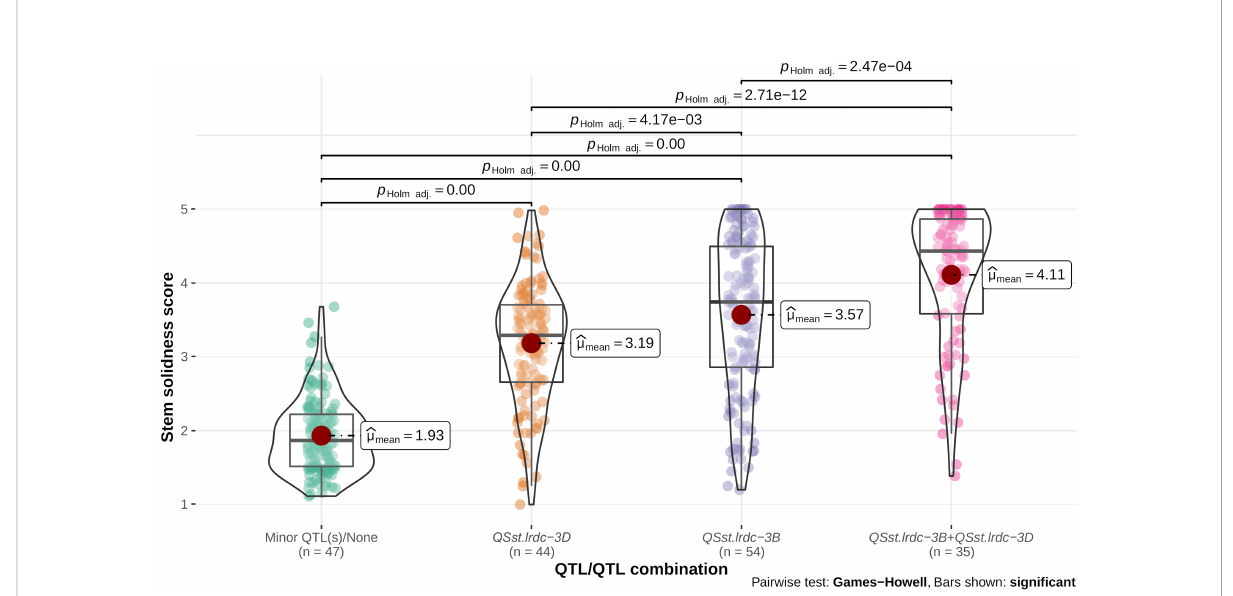
FIGURE 9 Violin plot and box plot distribution of stem solidness score in doubled haploid lines carrying (i) minor QTL(s)/none, (ii) major QTL QSst.lrdc-3D , (iii) major QTL QSst.lrdc-3B , and (iv) major QTL combination QSst.lrdc-3B and QSst.lrdc-3D in ‘ Sadash/P2711 ’ population. The violin plots (transparent) and different color- fi lled circles represent the data distribution. Quartiles and medians are represented by boxes and continuous lines (gray color), respectively. The mean is shown by dark red color dots. Whiskers extend to the farthest points that are not outliers. Signi fi cant differences are shown by bar and p